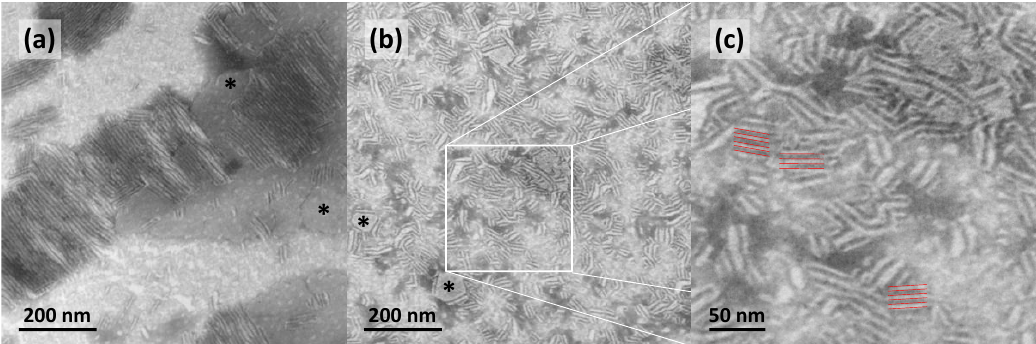
Figure 2. ( a – c ) Transmission electron microscopy (TEM) images of aqueous suspensions ( c = 0.03 mg mL − 1 in acetate buffer at pH = 5) of the bolalipid Me 2 PE-Gly(2C16)C32-OH at different magnifications; the inset in ( b ) is depicted in ( c ); the distance between layers is about 5 to 6 nm. The black asterisks in ( a , b ) point to lamellar sheets oriented parallel to the grid surface. The samples were prepared at about 22 °C and stained with uranyl acetate.